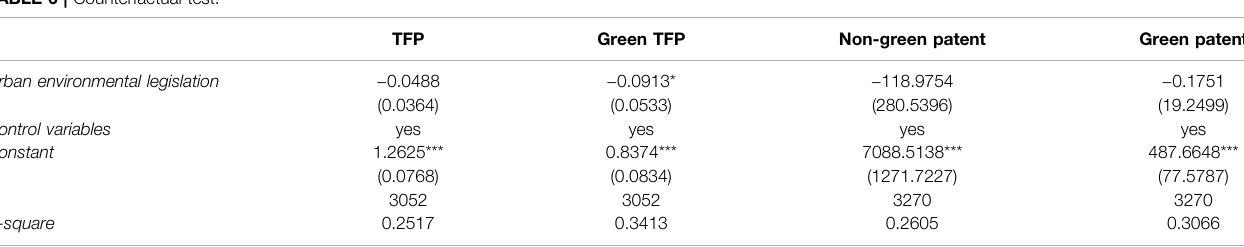
TABLE 6 | Counterfactual test.